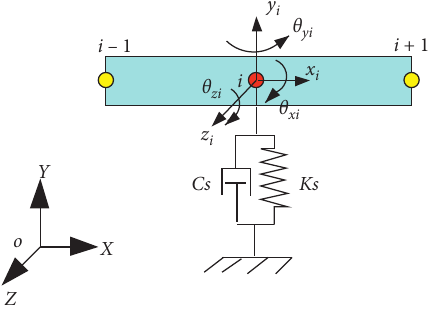
Figure 5: Spring-damper element for